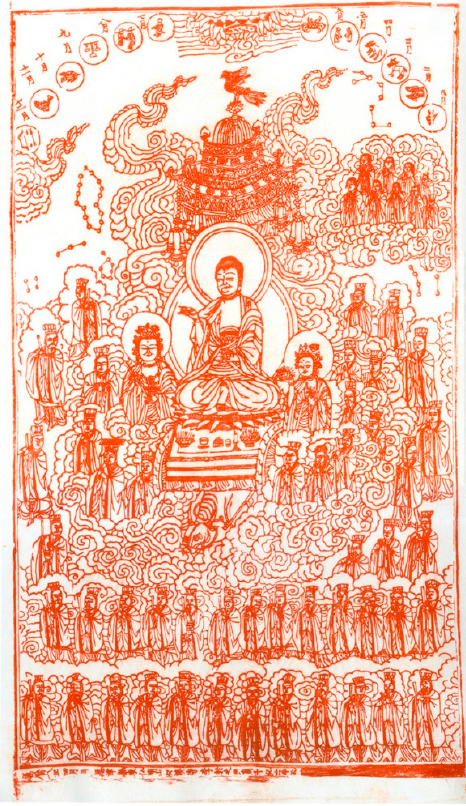
Figure 11. Descent of Tejaprabha Buddha (K. Chiseonggwang yeorae gangnimdo ), Published at Ssanggyesa Temple, Eunjin, Joseon (1580), 83.0 × 39.5 cm, Private collection. Photo by the author.